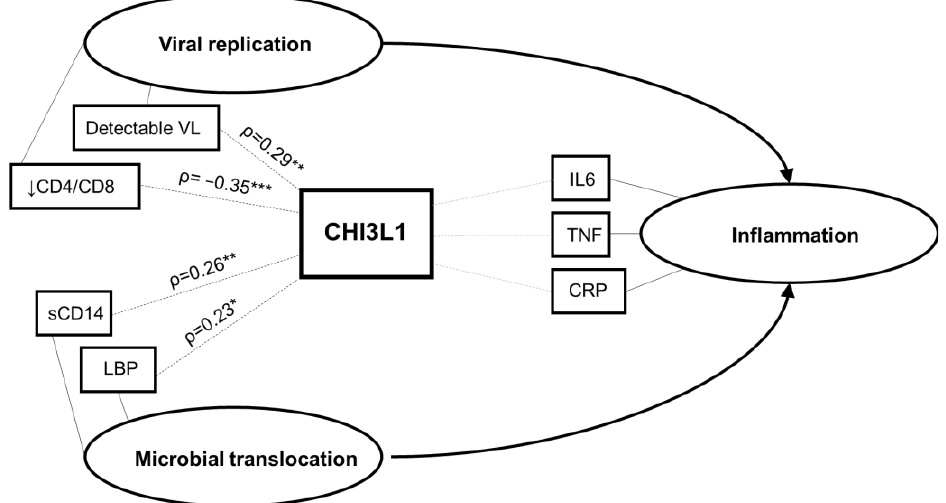
Figure 4. Conceptual framework. Based on the study findings, the hypothesized relationship between CHI3L1, viral replication, microbial translocation, and systemic inflammation is illustrated. Ovals represent latent constructs and rectangles represent measured variables. VL, viral load; IL-6, interleukin-6; TNF, tumor necrosis factor; CRP, C-reactive protein; sCD14, soluble CD14; LPB, lipopolysaccharide binding protein. * p < 0.05; ** p < 0.01; *** p < 0.001.